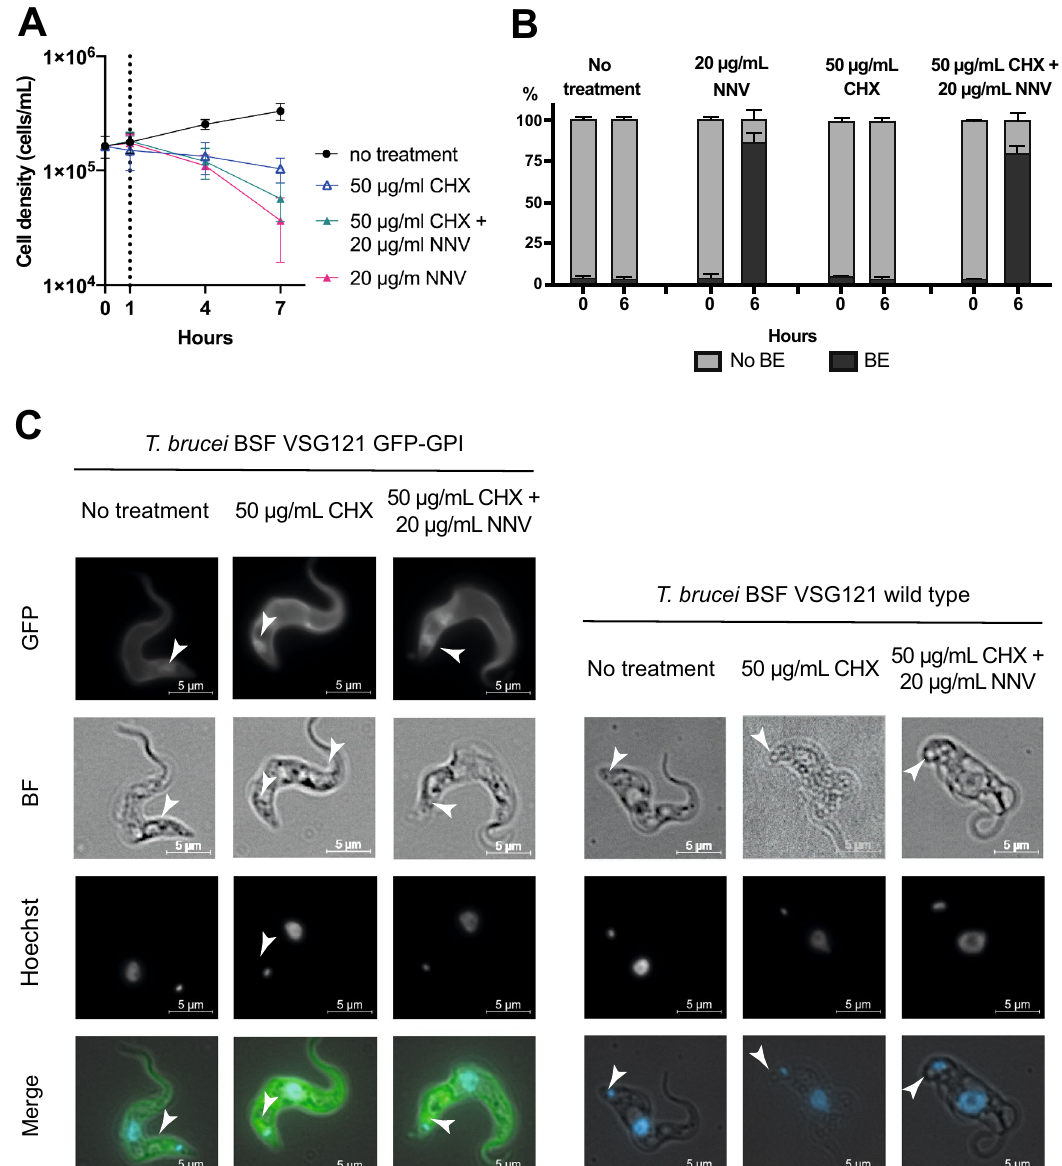
Figure 4. PLA 2 s seems to inhibit endocytosis of T. brucei plasma membrane components at the site of the flagellar pocket. ( A ) Protein synthesis inhibition lessens the cell growth phenotype caused by PLA 2 toxicity. Cells were incubated with cycloheximide (CHX), NNV, or both, and cell growth was monitored. T. brucei BSF VSG121 wild type cells incubated with CHX/NNV die more slowly than those cells incubated with NNV